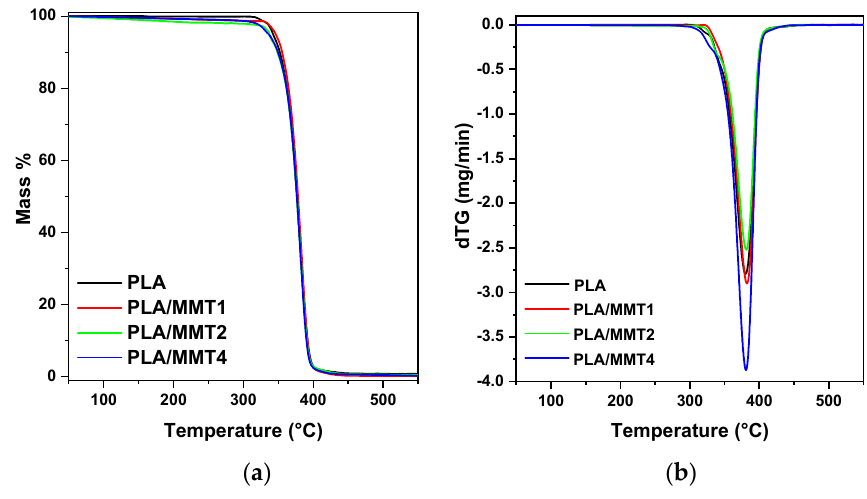
Figure 6. ( a ) TGA and ( b ) dTG curves of the filaments. Table 7. Thermal degradation characteristics of PLA neat, PLA, PLA/MMT filaments .